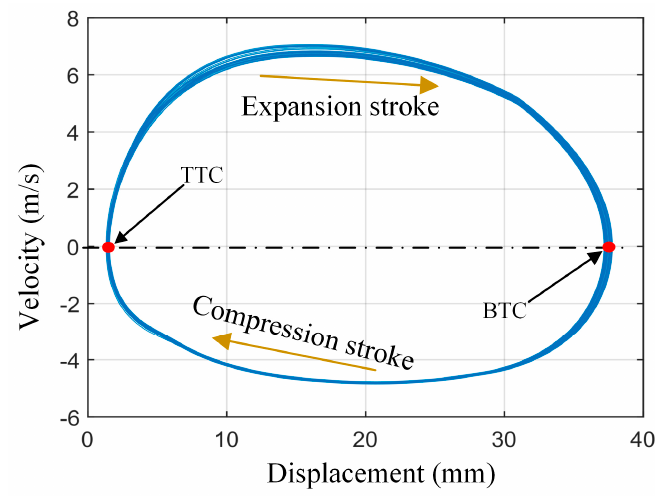
Figure 18. The velocity vs. the displacement (with control).